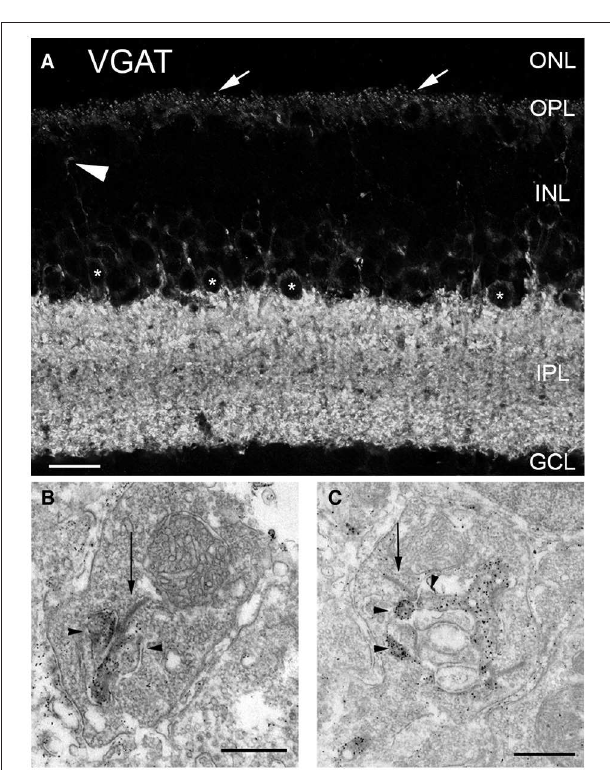
FIGURE 4 | Vesicular γ -aminobutyric acid transporter (VGAT) was present in horizontal cell endings. (A) VGAT antibody staining of a vertical section of mouse retina showed labeled puncta (arrows), weak immunolabeling in the OPL and strong immunolabeling in the IPL, and around cell bodies (*) of the proximal inner nuclear layer (INL). Arrowhead points to a VGAT-containing interplexiform process. ONL, outer nuclear layer; GCL, ganglion cell layer. Scale bar, 20 µ m. (B,C) VGAT immunoreactivity is localized in horizontal cell synaptic endings at photoreceptor synapses. Electron micrographs illustrate the dark and granular DAB reaction product of the VGAT immunoreactivity in terminals of horizontal cells of mouse (B) and rat (C) retina. Arrows indicate photoreceptor synaptic ribbons. Arrowheads indicate horizontal cells. Scale bars, 0.5 µ m in (B,C) . (Modified from (Cueva et al.,